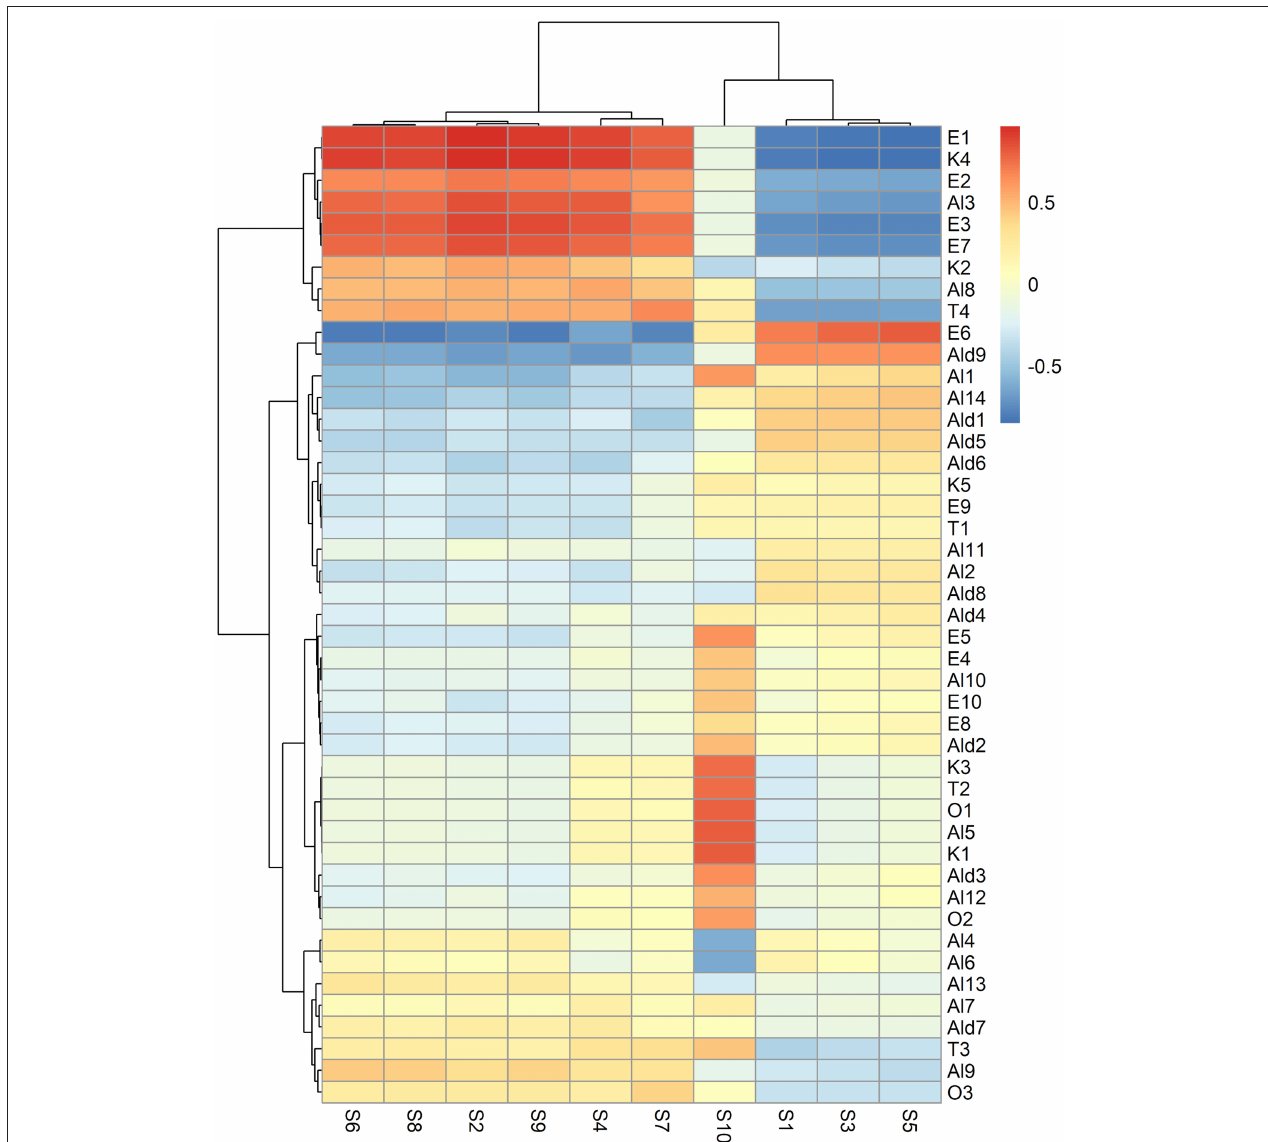
FIGURE 6 | Heatmap representing the correlation between VOCs and E-nose data sensors. In the heatmap, the colour of each cell depends on the value of the Pearson correlation coefficient between the VOC and E-nose data sensor. VOCs and E-nose data have been clustered based on the Euclidean distance and Ward’s method. As a result, specific groups of VOCs positively or negatively correlated to specific groups of E-nose sensors can be visually discovered, searching the regions of the map with the highest intensity (red or blue,